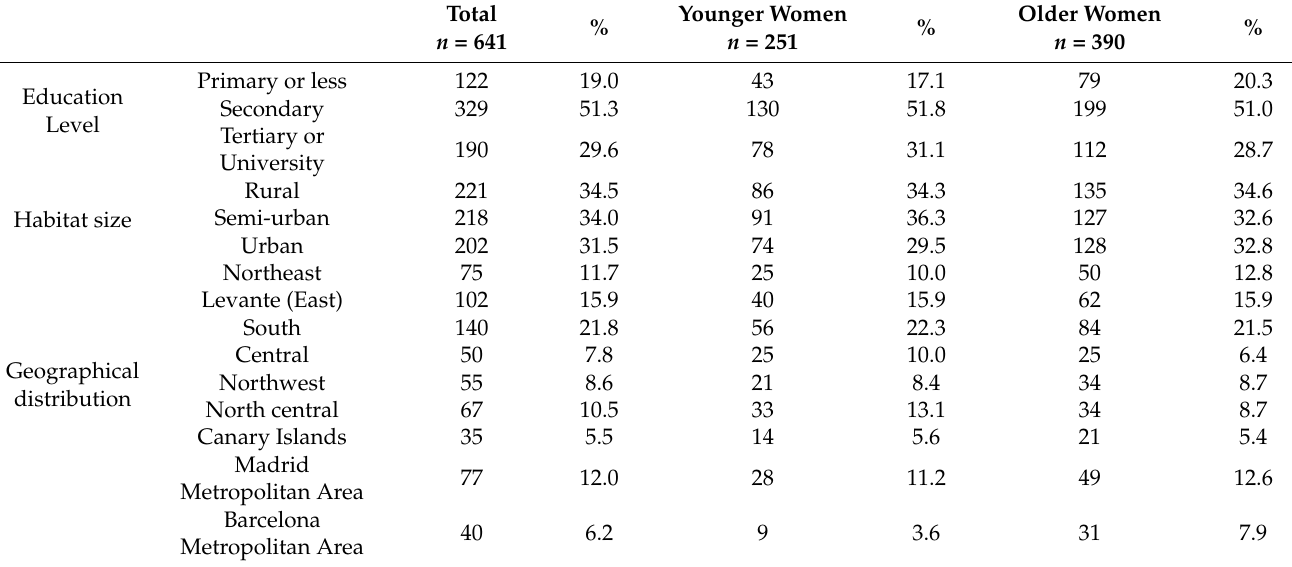
Table 1. Description of the ANIBES study sample (18–45 years).